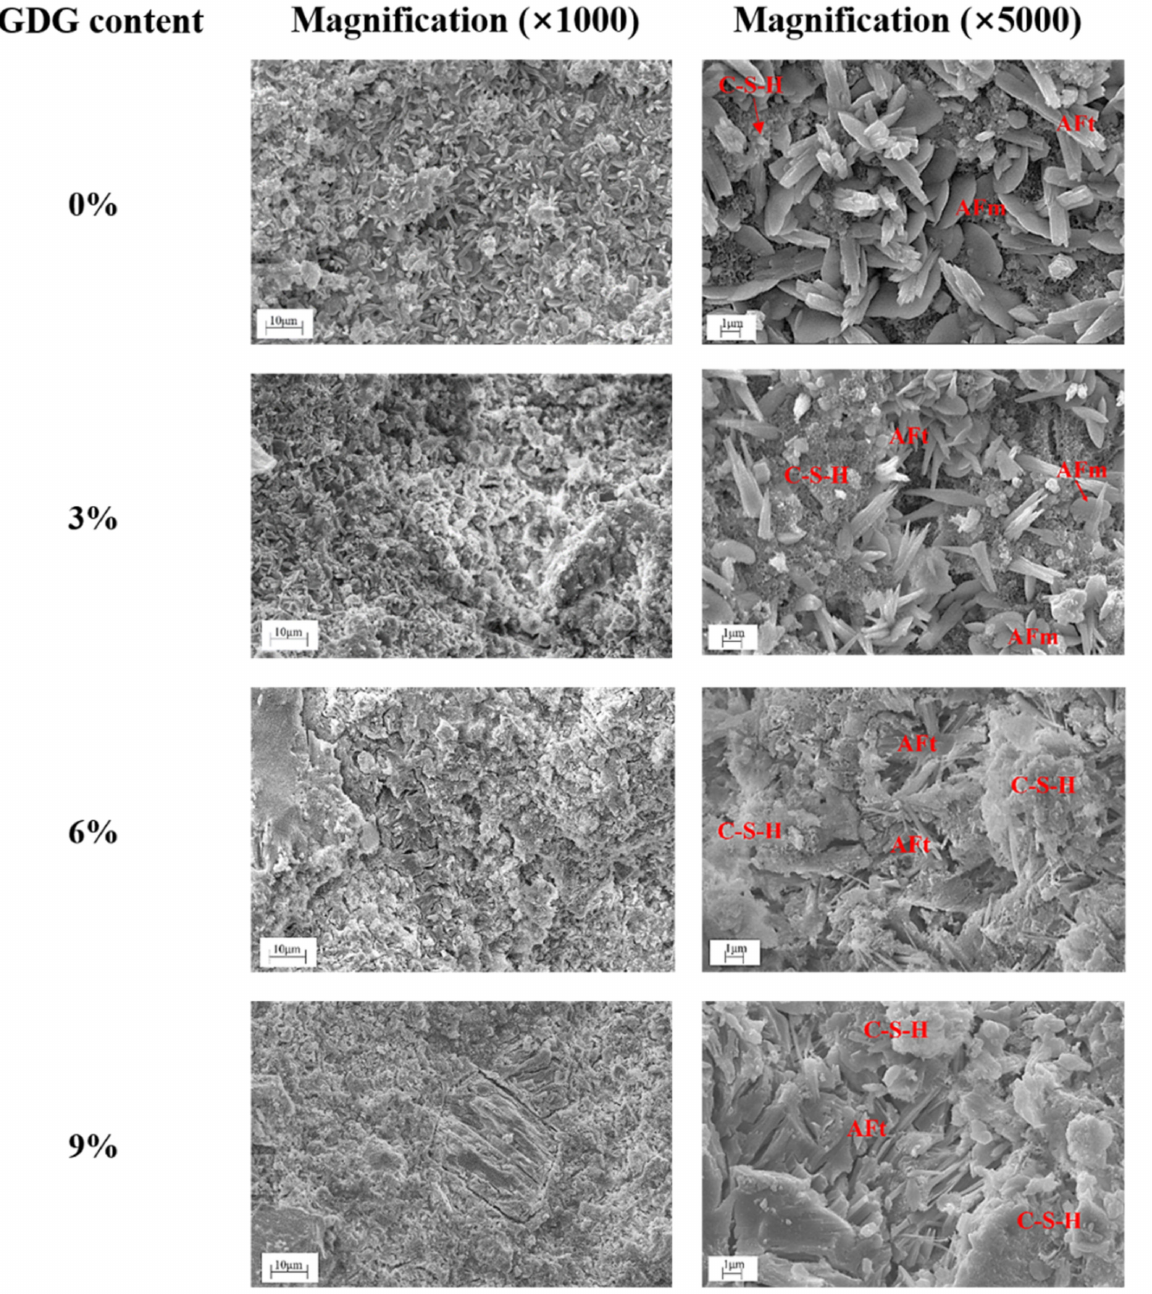
Figure 12. SEM images of CSAC-GGBFS mixtures with different FGDG content hydrated for 120